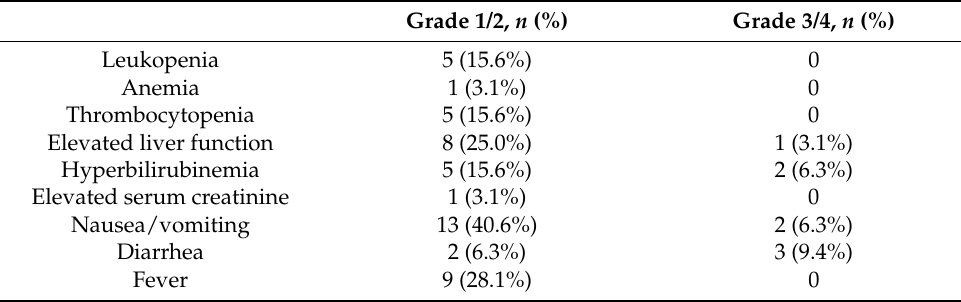
Table 4. Adverse events related to